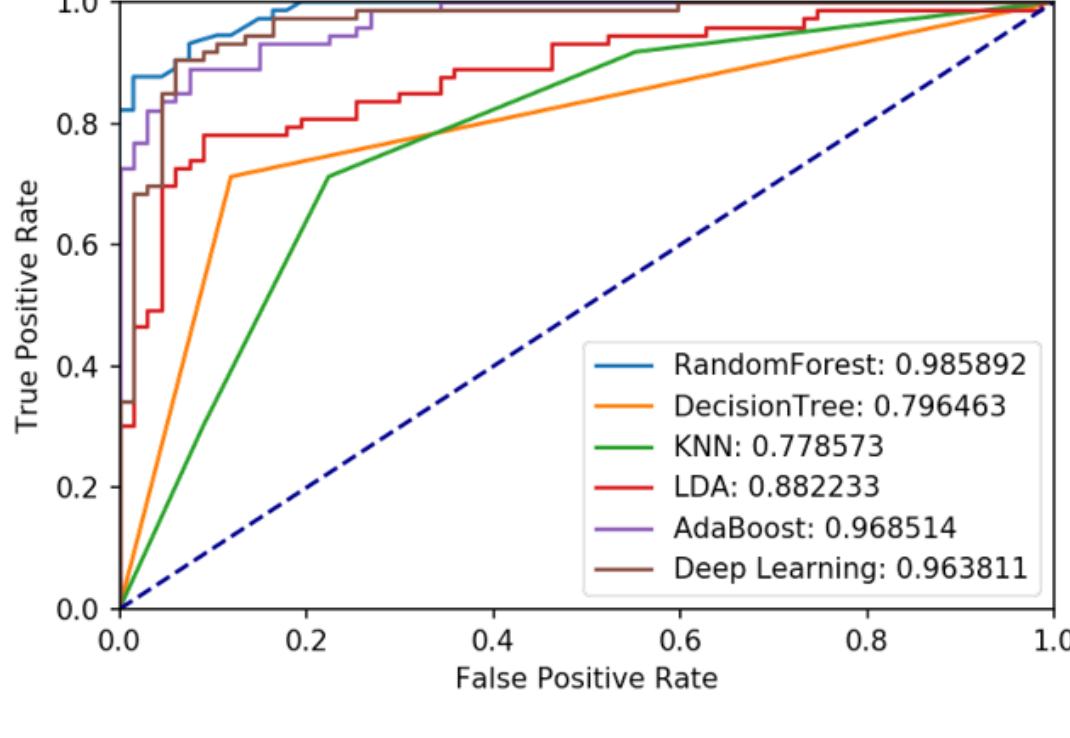
Figure 12. Receiver operating characteristic (ROC) curve and area under the receiver operating characteristic curve of all models. AE: acute exacerbation; KNN: k-nearest neighbor; LDA: linear discriminant